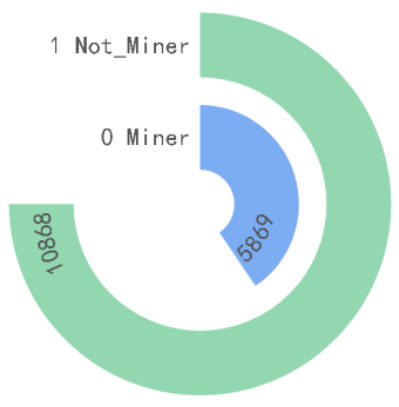
Figure 10. Kaggle malware sample.